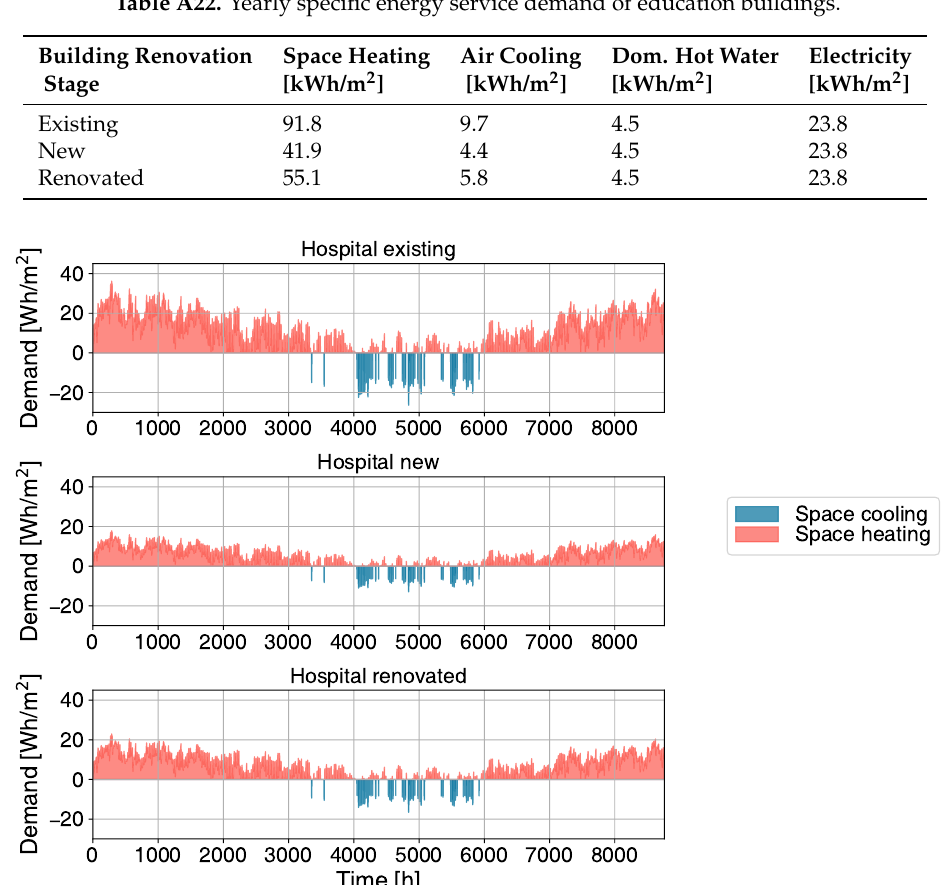
Figure A5. Hourly specific energy service demand of education buildings. Table A22. Yearly specific energy service demand of education buildings.